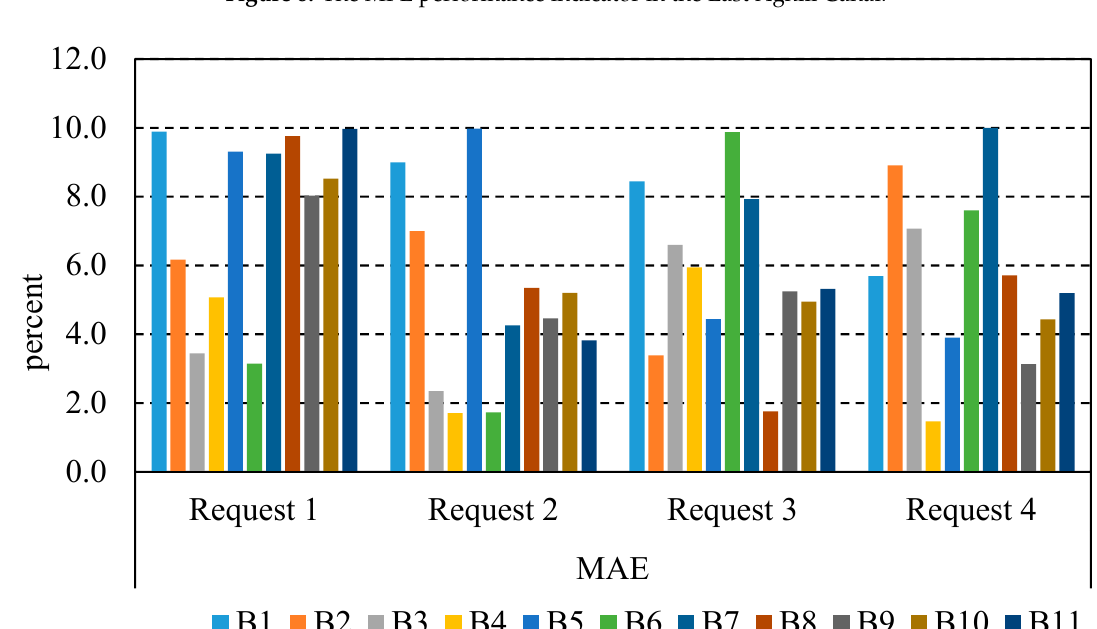
Figure 9. The maximum absolute error (MAE) performance indicator in the East Aghili Canal.